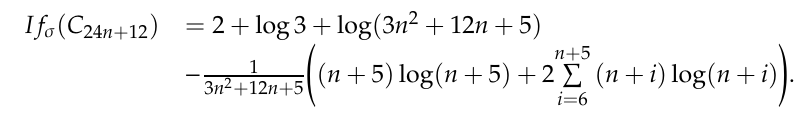
Figure 8. The molecular graph of the fullerene C 12 n + 2 .